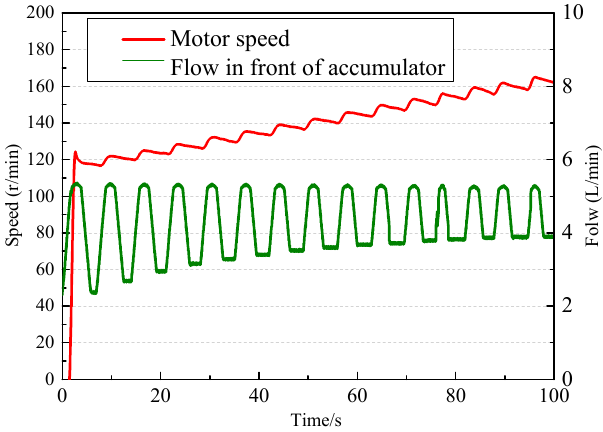
Figure 15. Motor speed and flow curves in front of the accumulator.